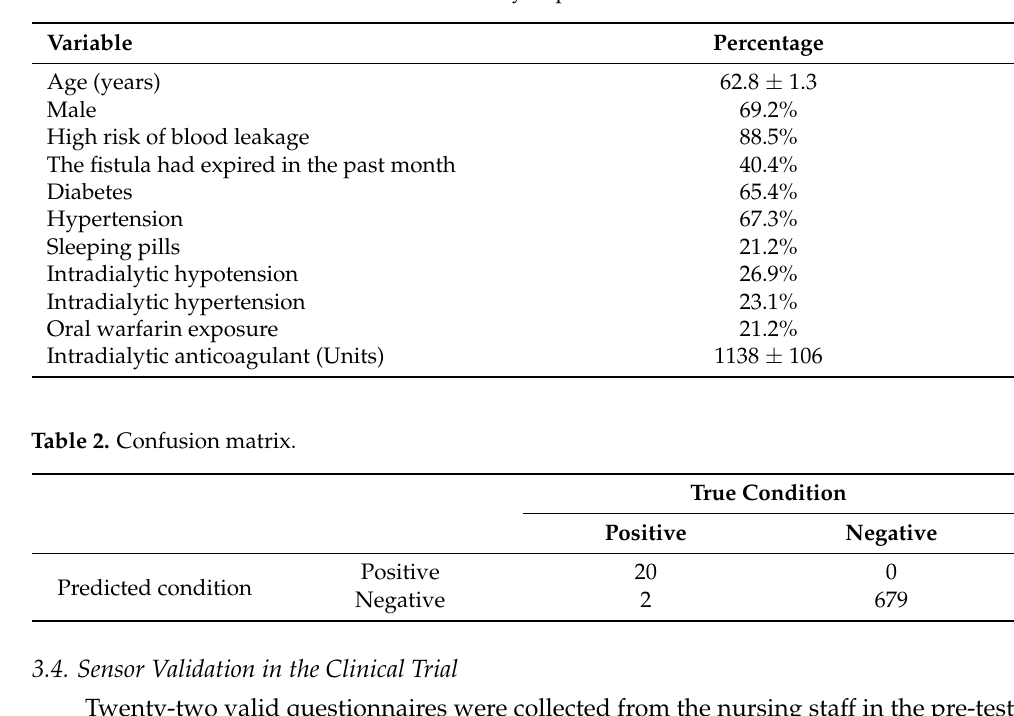
Table 1. Characteristics of the enrolled hemodialysis patients.